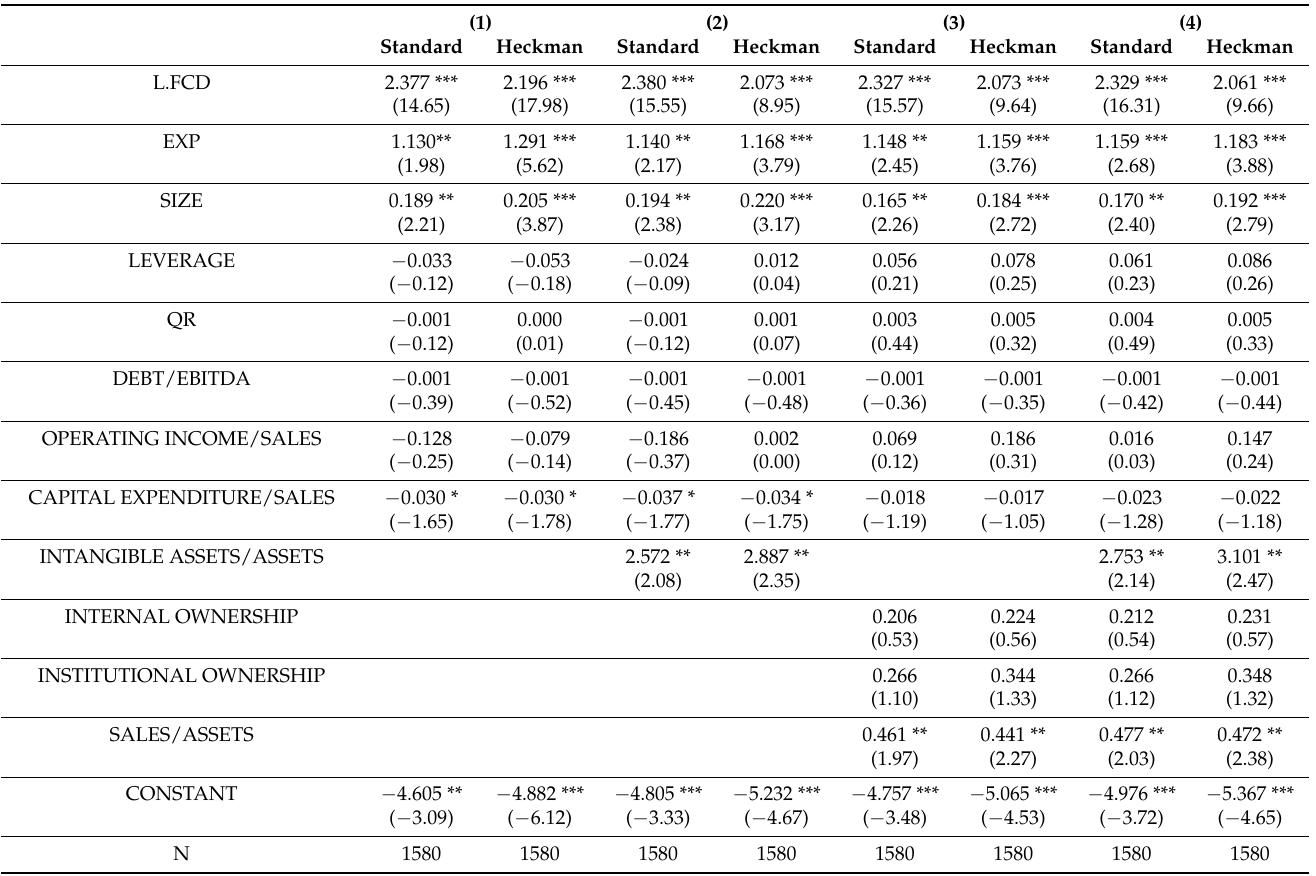
Table 5. The dynamics of foreign currency derivatives